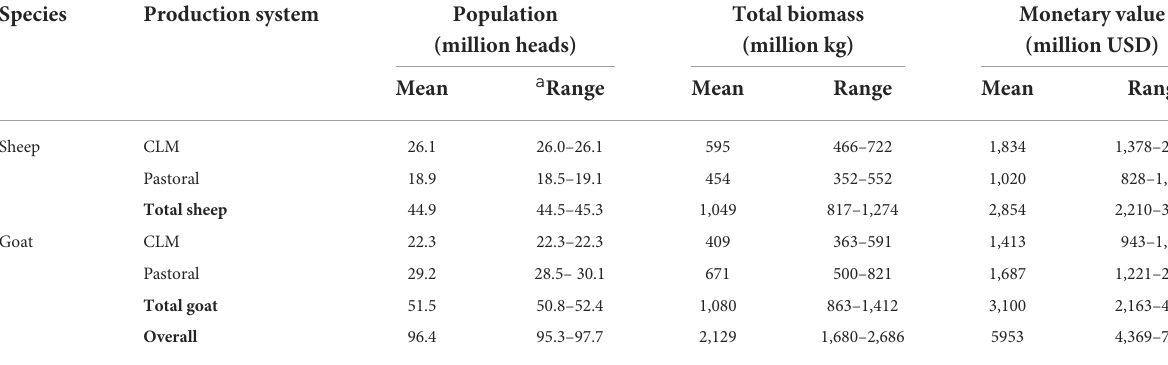
TABLE 3 The simulated number, biomass, and the monetary value of the small ruminant population in 2021.